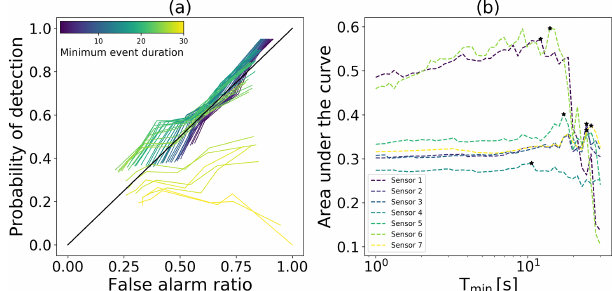
Figure 8. (a) POD–FAR curves for sensor 1 for different minimum event durations T min (colors). (b) Area under the POD–FAR curve with T min for all sensors (colors). The stars show the T min value with the largest area under the curve for each sensor.